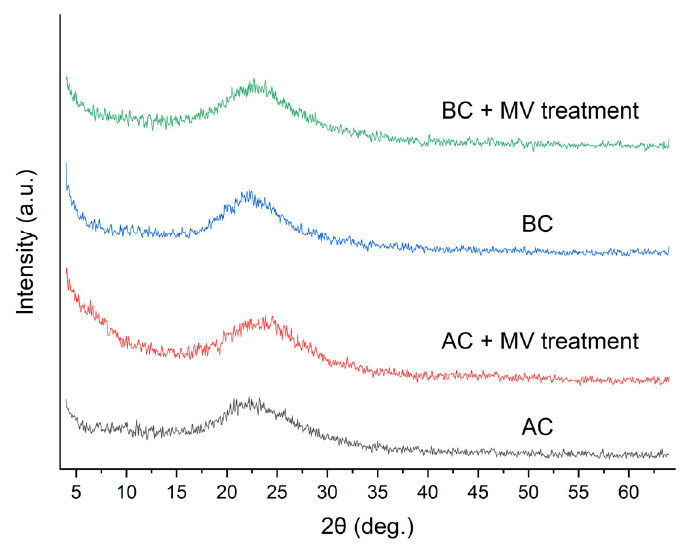
Figure 5. Diffractograms of silica filler: AC—hydrolysis with acid catalyst; AC + MV treatment— hydrolysis with acid catalyst followed by microwave treatment; BC—Hydrolysis with base catalyst; BC + MV treatment—hydrolysis with base catalyst followed by microwave treatment.